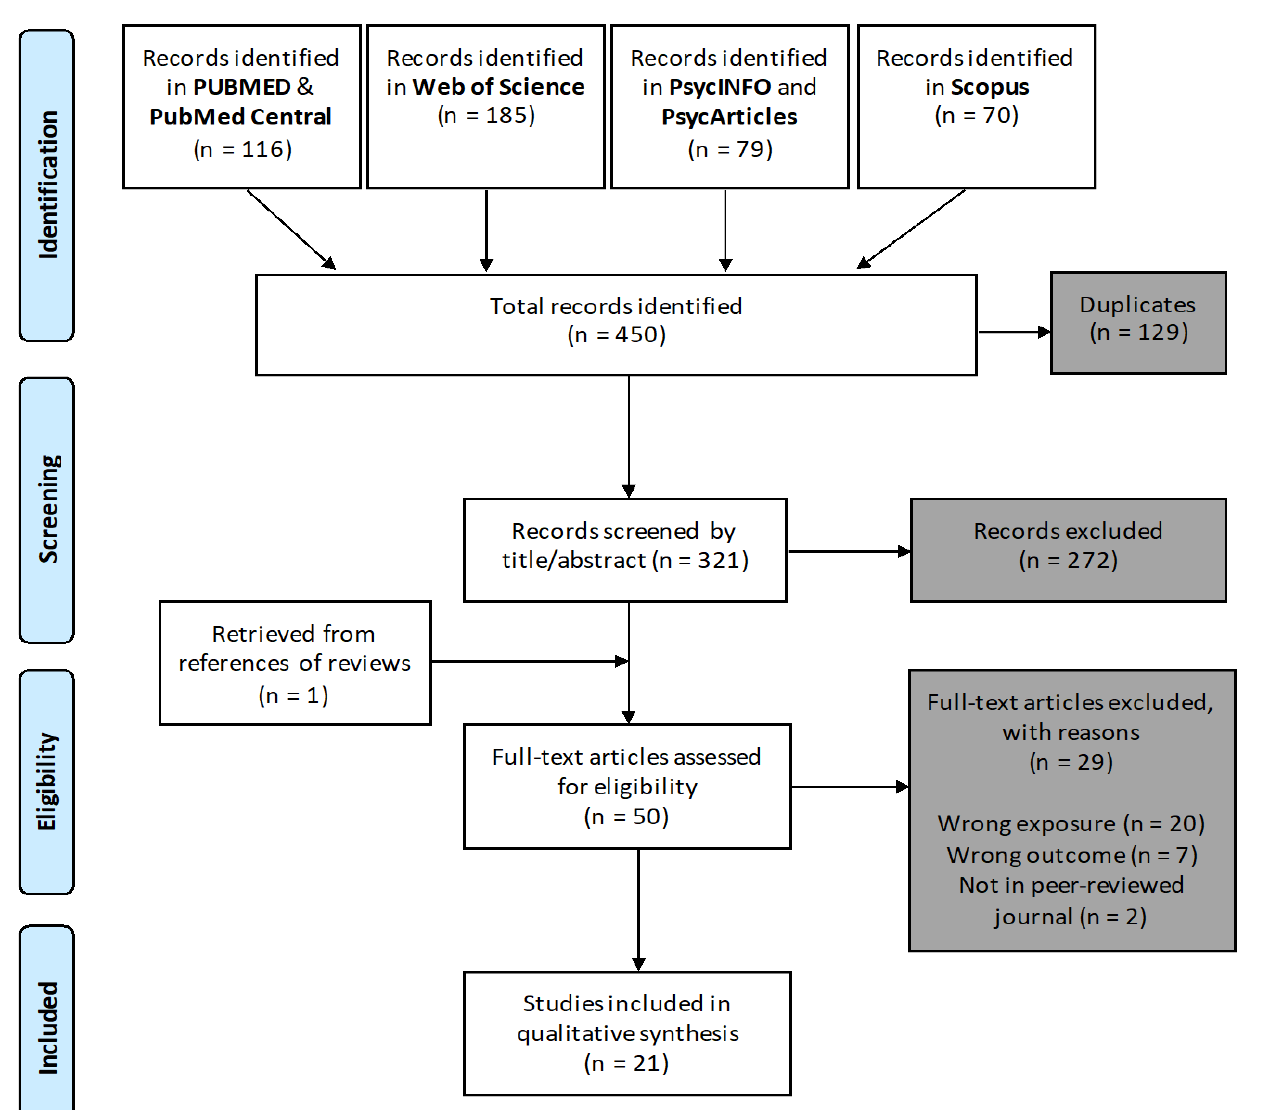
Figure 1. Preferred Reporting Items for Systematic Reviews and Meta-Analyses (PRISMA) flow diagram depicting the number of reports screened and included in this systematic review. Source: [15].